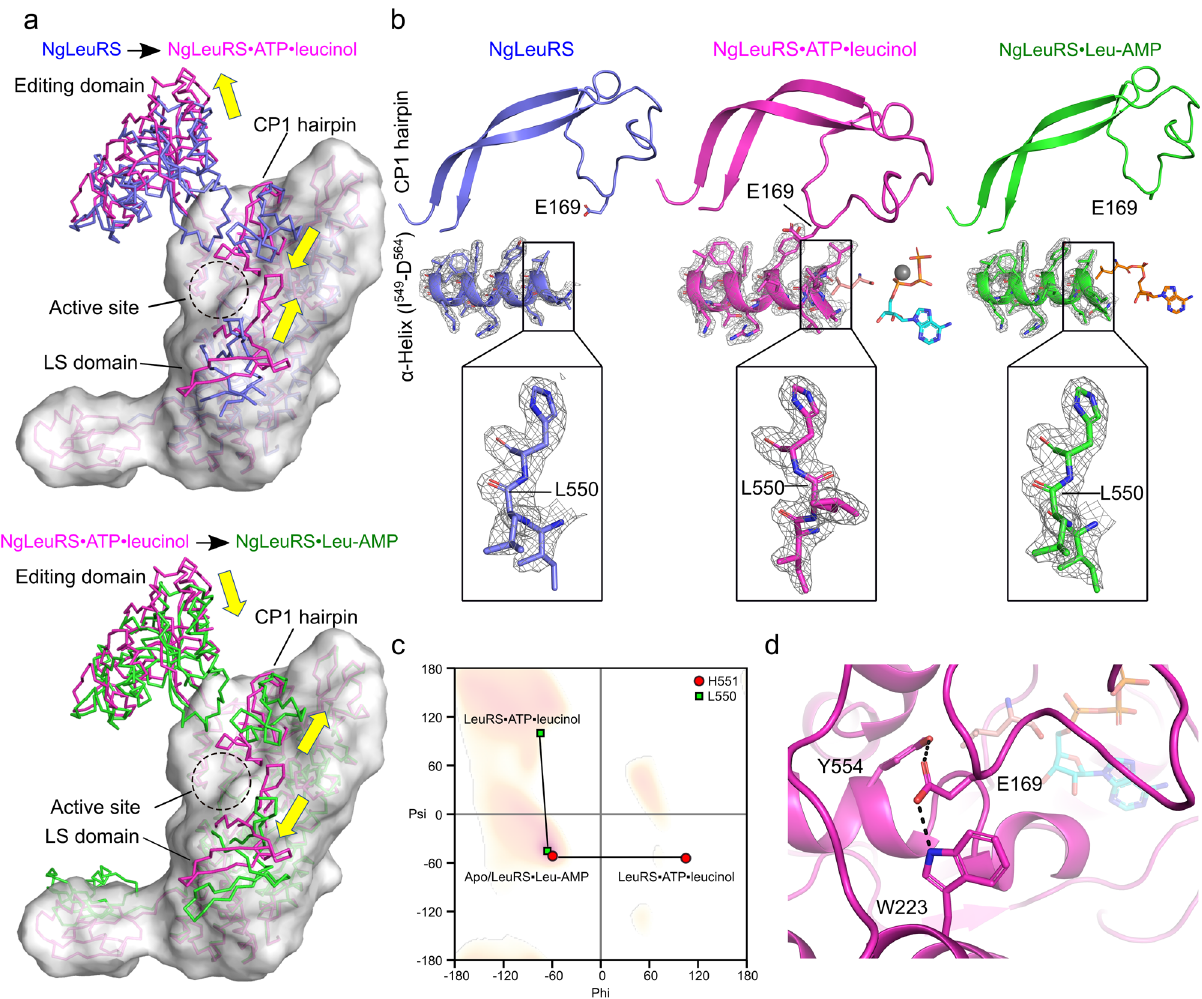
Fig. 3 Structural comparison of different catalytic states of NgLeuRS. a Top, ribbon representation of the superposition of the ternary structure of NgLeuRS·ATP·leucinol (magenta) with NgLeuRS (slate). Bottom, superposition of the ternary structure of NgLeuRS·ATP·leucinol (magenta) with NgLeuRS·Leu-AMP (green). In both panels the aminoacylation domain, CP2, Zn2, ACBD and CTD of the NgLeuRS·ATP·leucinol structure are additionally shown as a surface representation. b Top panels, the relative position of the CP1 hairpin (cartoon backbone representation) to the L550-containing α -helix (cartoon and stick representation) in different catalytic states. Ligands are shown as sticks representations while the Mg 2 + ion is shown as a gray sphere. Bottom, zoom of the L550 region. 2Fo-Fc electron density maps countered at 1.5 σ (gray mesh). c Comparison of the Ramachandran plot of L550 (green square) and H551 (red circle) in NgLeuRS/NgLeuRS·Leu-AMP and NgLeuRS·ATP·leucinol structures. d Polar interactions between E169 in the CP1 hairpin and surrounding protein residues in the NgLeuRS·ATP·leucinol complex. H-bonds are shown as black dashed